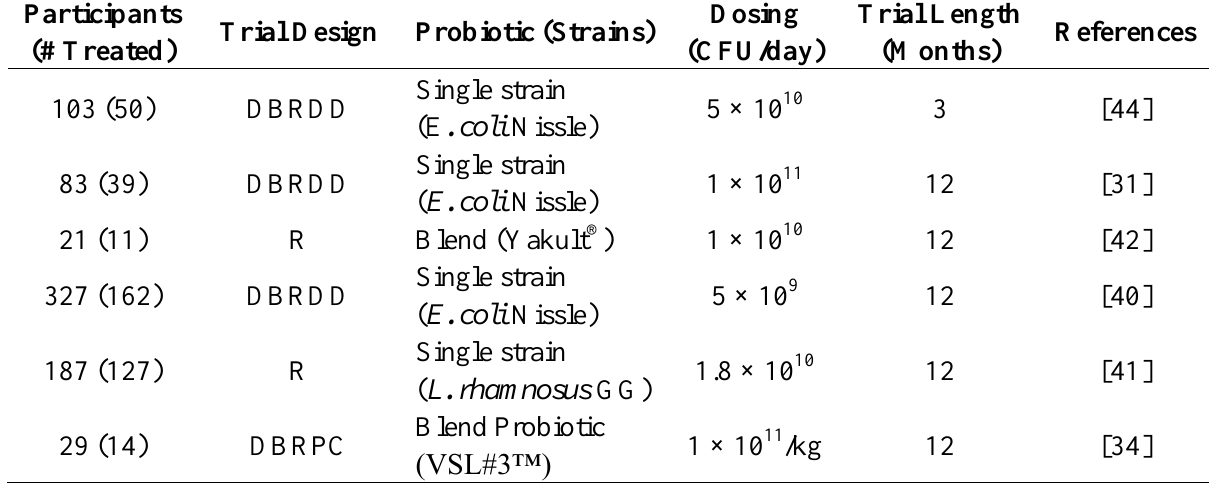
Table 2. Randomized Trials of probiotics used as maintenance therapy for ulcerative